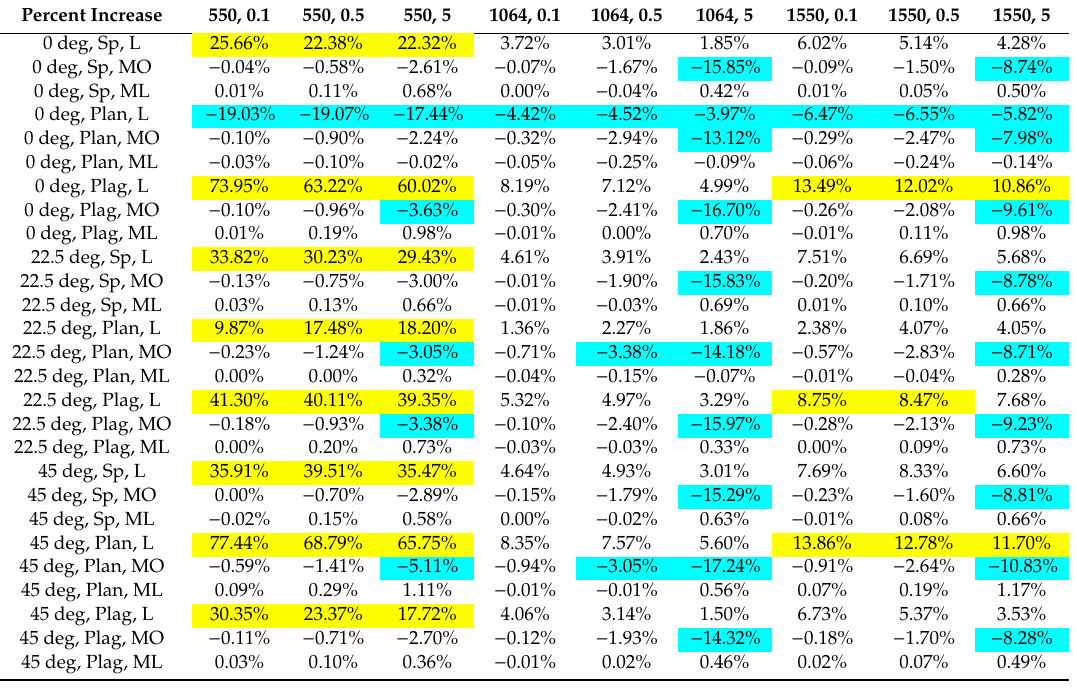
Table A1. Percent increase statistic for each configuration. The shorthand for the descriptions of the columns are wavelength in nm and footprint in m, while the rows are zenith view angle in degrees, LAD type (Sp–spherical, Plan–planophile, Plag–plagiophile), and leaf BSDF (L–Lambertian, MO–model reflectance non-transmitting, ML–model reflectance Lambertian transmittance). Yellow highlights are the top 10% while the blue highlights are the bottom 10% of the data